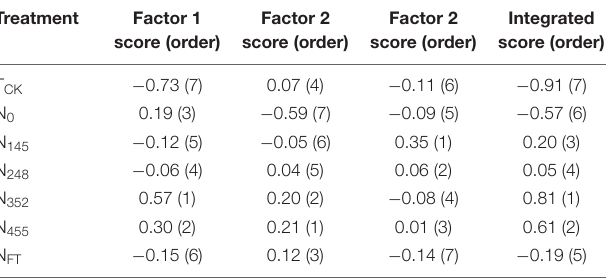
TABLE 3 | The integrated score of different treatments. Treatment